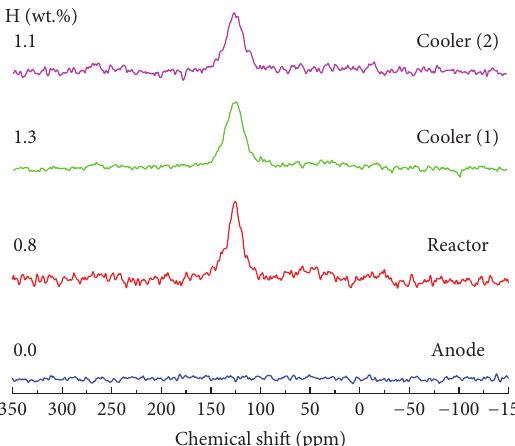
Figure 5: XRD patterns recorded for the carbon residues collected at different points in the Ar plasma apparatus.